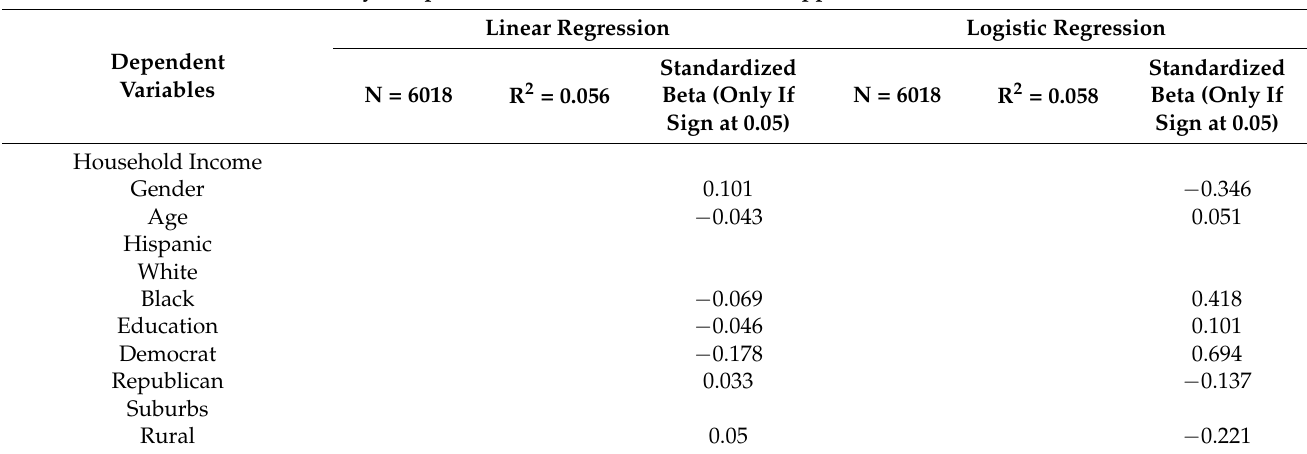
Table A2. Linear and Logistic Regressions of Likelihood of Vaccine Adoption (Very, Somewhat, Not Too, Not at All) by Demographics.